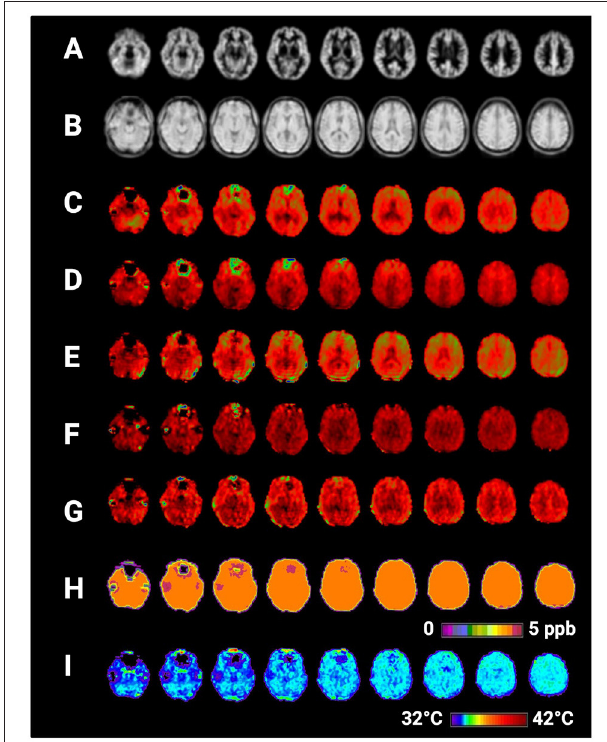
FIGURE 2 | Selected axial slices showing raw metabolite and brain temperature maps derived from a single participant’s volumetric magnetic resonance spectroscopic imaging data (MRSI) data. Shown are (A) normalized gray matter volumes, (B) water reference signal, (C) total creatine (creatine + phosphocreatine), (D) total choline, (E) NAA (N-acetylaspartate), (F) myo-inositol, (G) Glx (combined signal from glutamine and glutamate), (H) frequency difference between water and creatine ( 1 H20 − CRE ), (I) brain temperature calculated according to the equation T CRE = − 102.61( 1 H20 − CRE ) + 206.1 ◦ C. Raw MRSI data were visualized within the Metabolite Imaging and Data Analysis System (MIDAS) software package, and the figure was